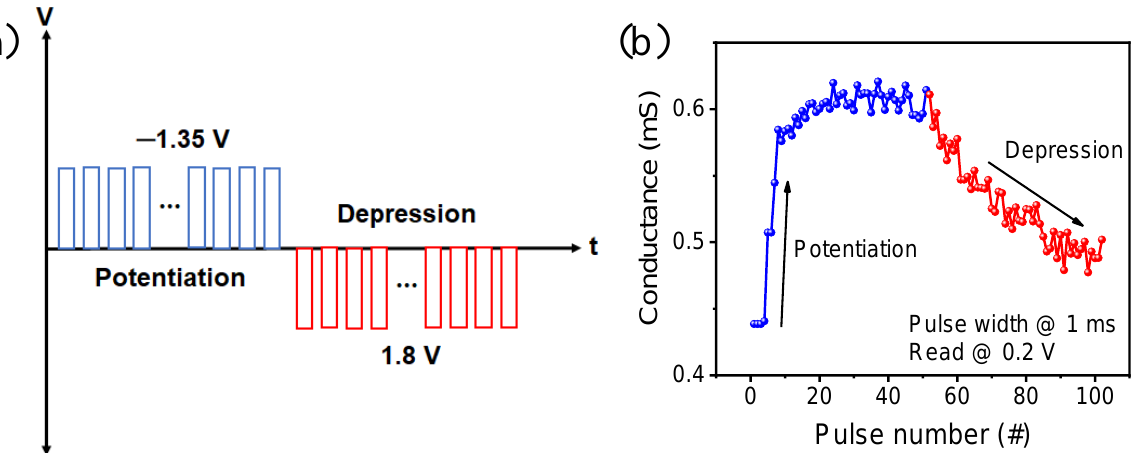
Figure 7. ( a ) Identical 50 pulses for potentiation and depression characteristics; and ( b ) conductance change in potentiation (blue)/depression (red).